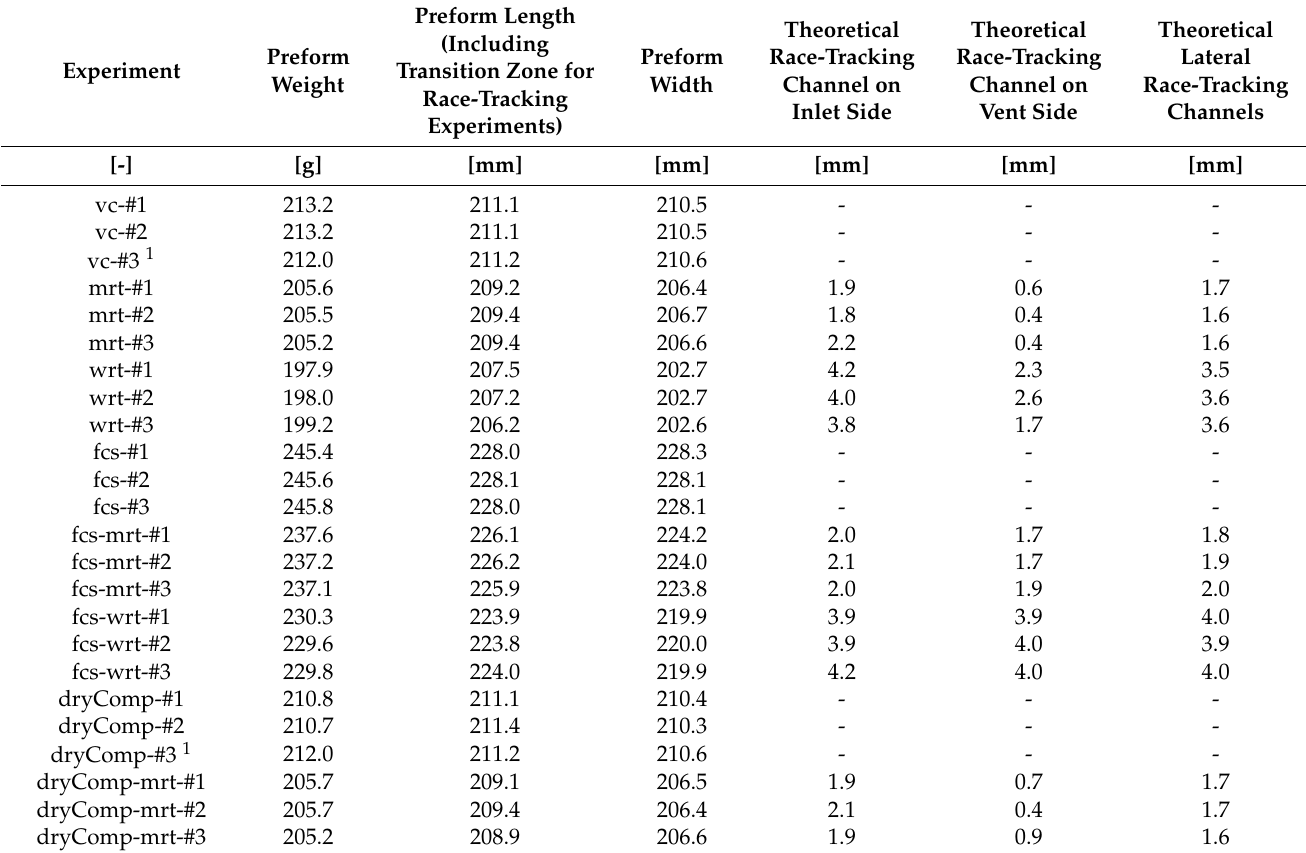
Table A2. Preform data and resulting theoretical race-tracking channel width (neglecting preform placement tolerances). Experiment